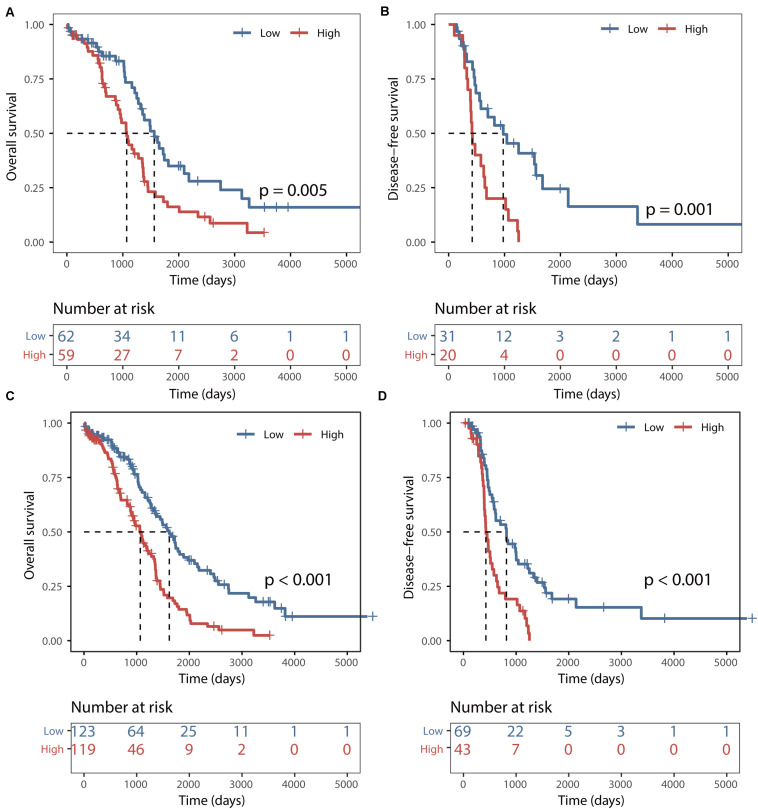
Validation of the BRCALncSig. Kaplan–Meier survival curves of overall survival between high-risk and low-risk patients in the testing set (A) and entire TCGA set (C). Kaplan–Meier survival curves of disease-free survival between high-risk and low-risk patients in the testing set (B) and entire TCGA set (D).